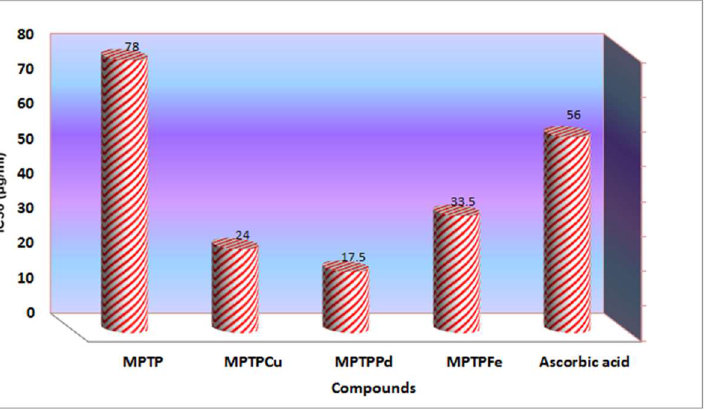
Figure 11. Trends in inhibition of DPPH˙ radical by the tested ligand (95) & its chelates (96–98). Reproduced from the permission of ref. [156].